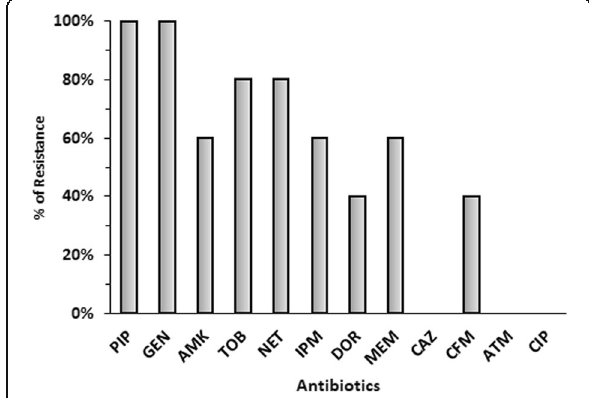
Fig. 2 Antibiotic resistance of MAR P. aeruginosa isolates against commonly used antibiotics